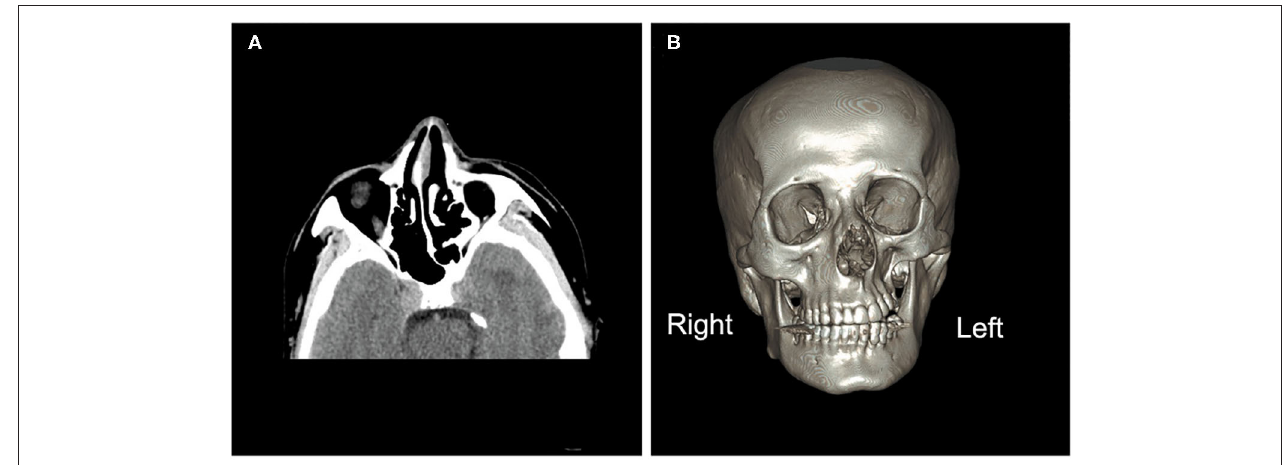
FIGURE 1 | Brain computed tomography images. (A) Brain computed tomography (axial image) depicting under-development of the bone structure on the left side of the face compared with the right, including the nasal bone, nasal septum, sphenoid bones, and ethmoid bones. (B) A three-dimensional image of the brain depicting atrophy of the orbit, zygomatic bone, and teeth on the left